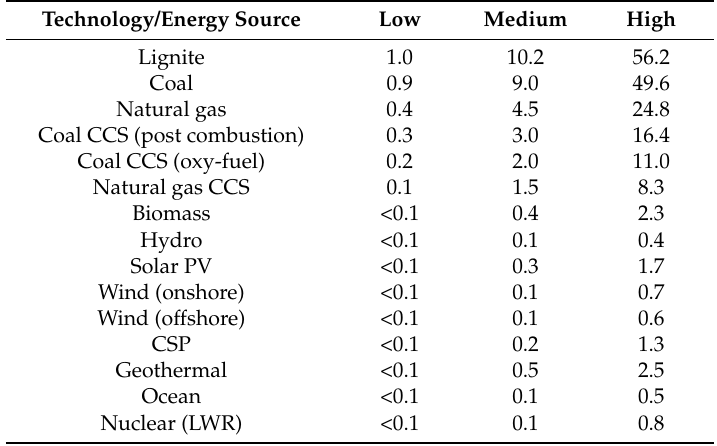
Table 6. Lifecycle GHG emissions costs of electricity generation technologies assuming a social cost of carbon of € 2015 11 (low), € 2015 114 (medium) and € 2015 626 (high) per ton of CO 2 -equivalent (in € -cent 2015